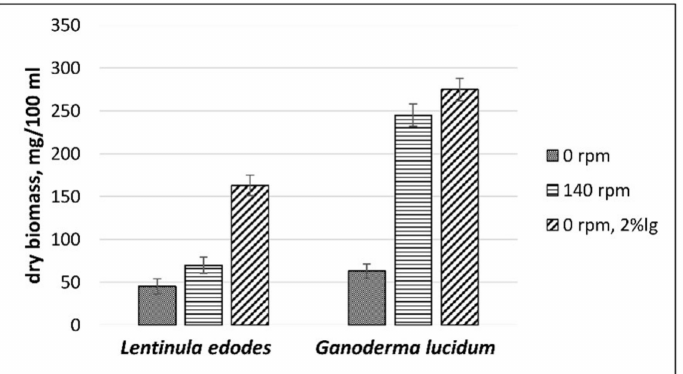
Figure 2. Effect of agitation at 140 rpm and the addition of CS lignin on the production of mycelial